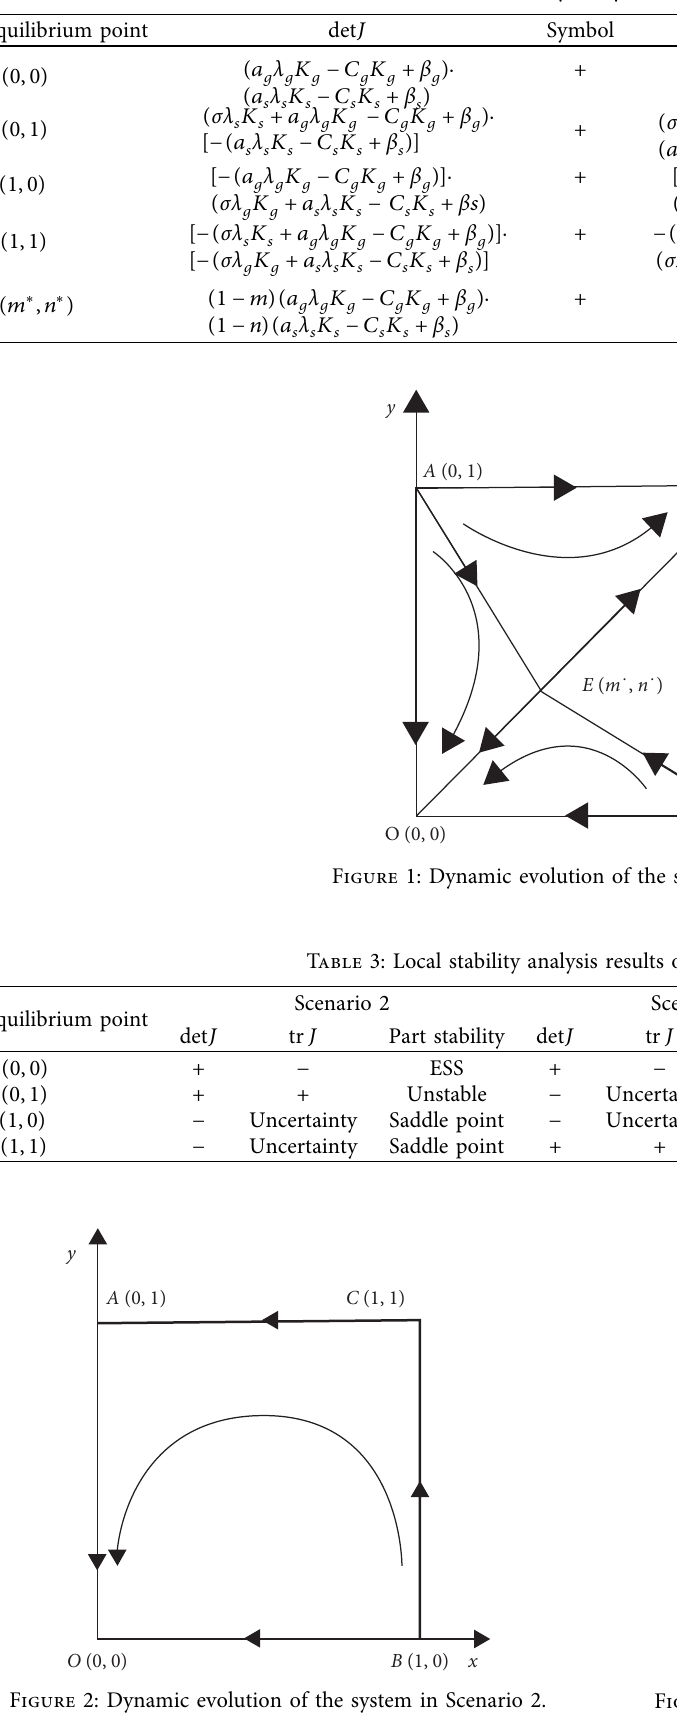
Table 2: Local stability analysis results of Scenario 1.